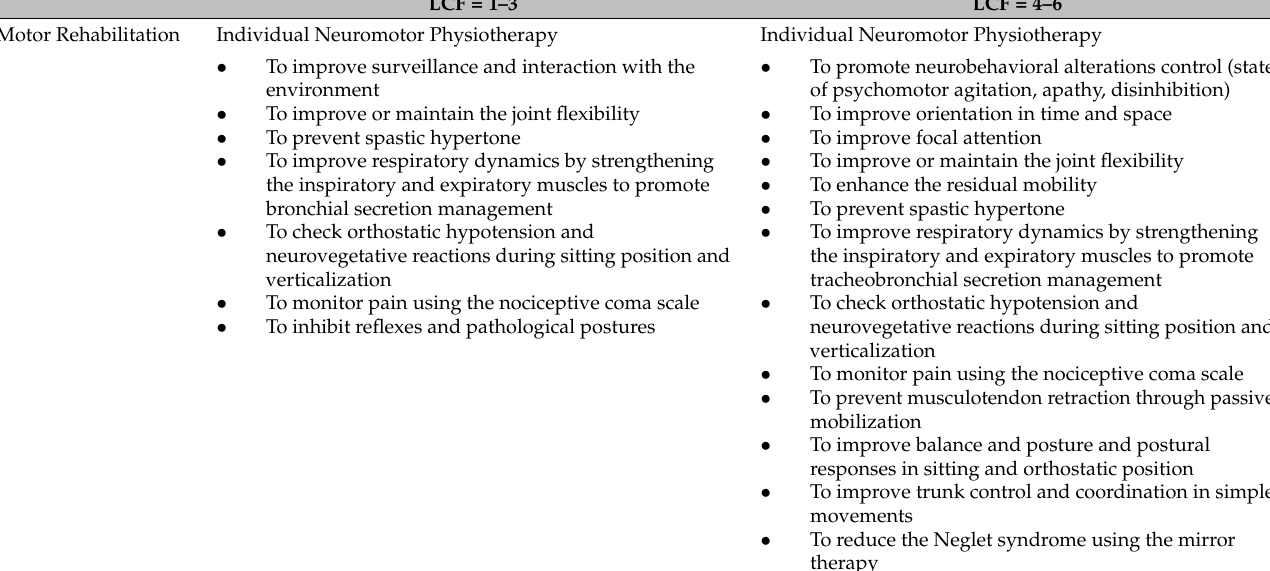
Table A1. Rehabilitative